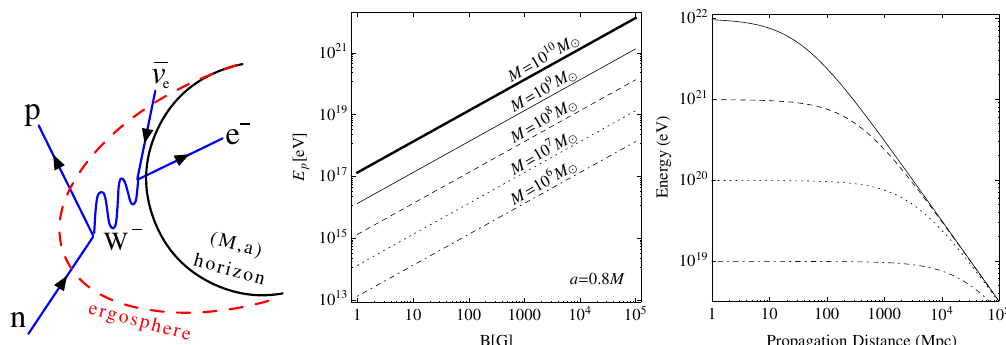
Figure 2. ( left ) Feynman diagram of the beta-decay in ergosphere of spinning black hole. Proton after decay is accelerated by induced black hole charge and escapes to infinity. ( middle ) Proton energy in ultra-efficient MPP is plotted against magnetic field for different values of black hole mass. ( right ) The drop of proton energy over the distance comparable to local cosmological structures undergoing synchrotron radiation in a magnetic field of order of 10 − 5 G. Applying MPP to the beta-decay of free neutron in vicinity of a standard supermassive black hole (SMBH) with mass M = 10 9 M (cid:12) and magnetic field of strength B = 10 4 G, one can get proton